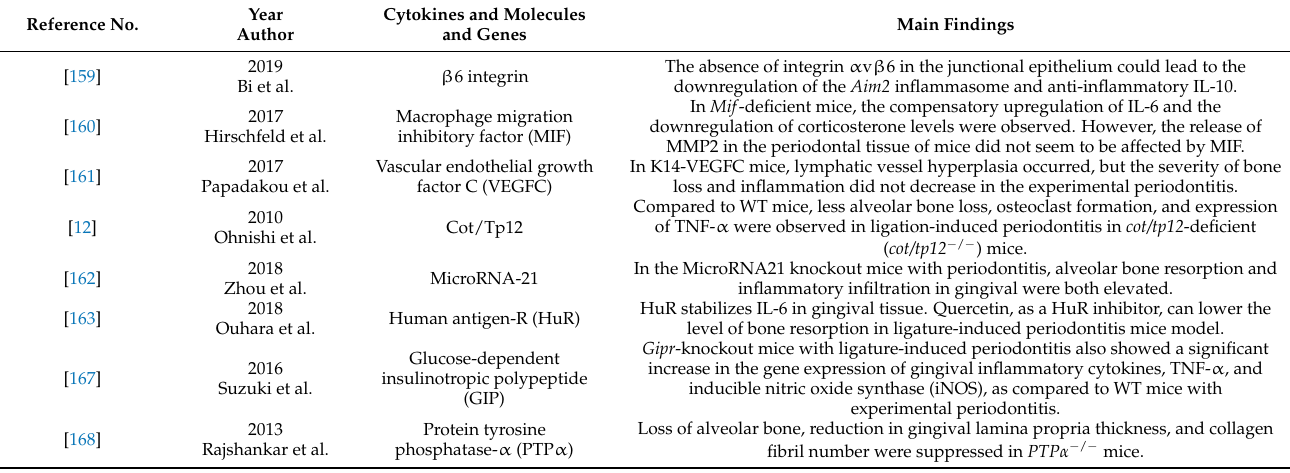
Table 6. Summary of cytokines, molecules, and genes in immune responses in ligature-induced periodontitis model in mice. Reference